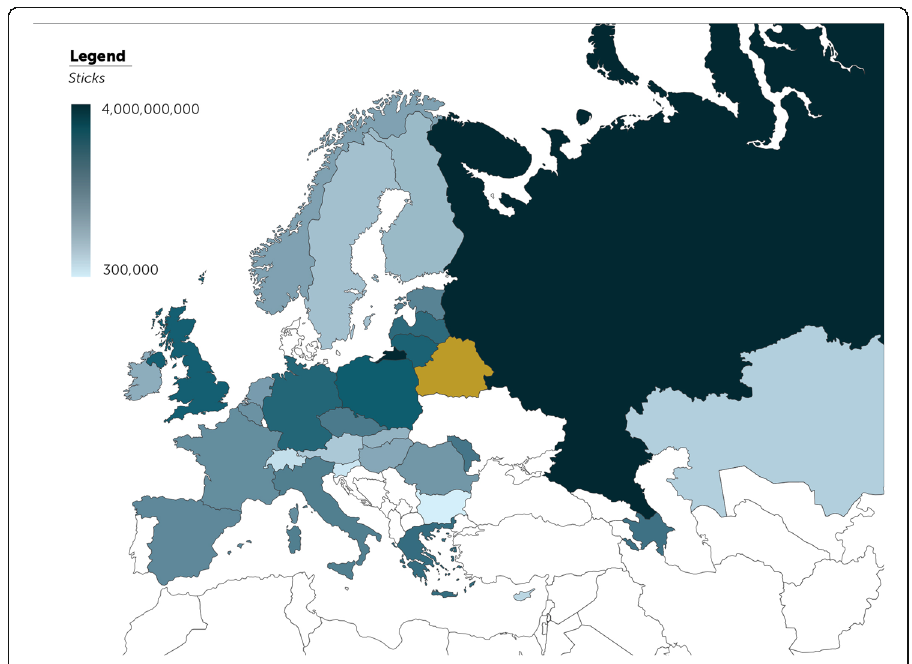
Fig. 3 Consumption of illicit cigarettes originating in Belarus,